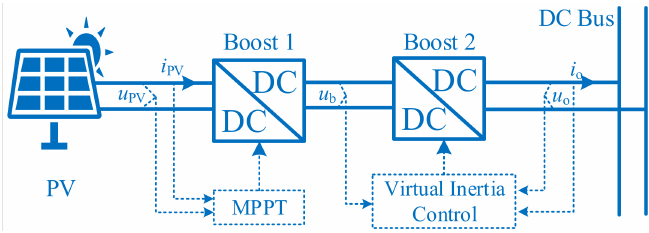
Figure 7. Schematic diagram of PV system in dc MGs.